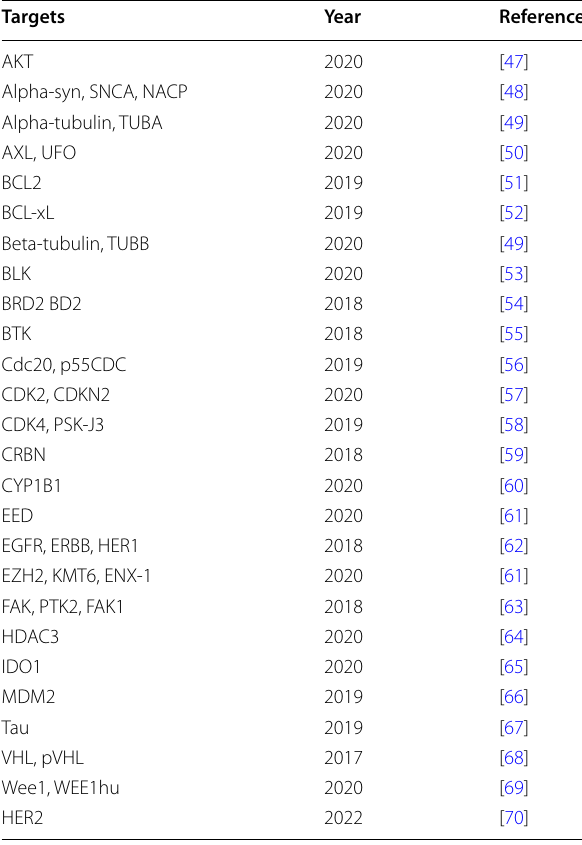
Table 2 PROTACs first reported in the last 5 years (2017–2022) Targets